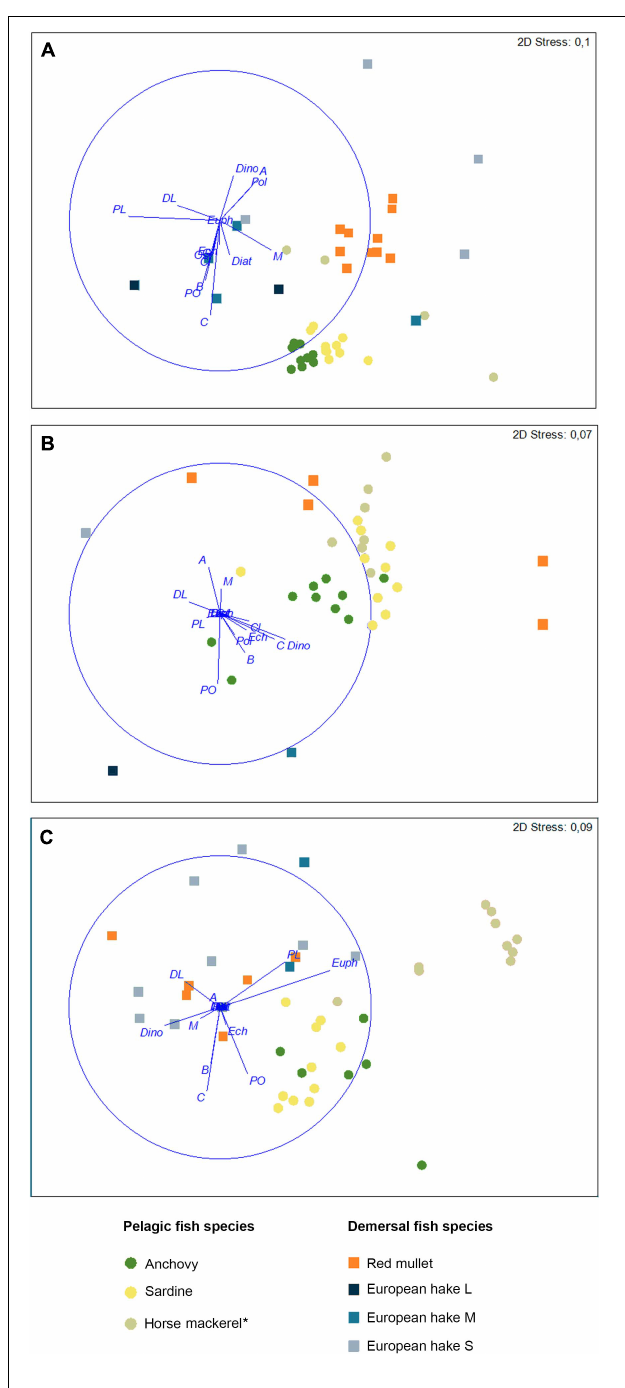
FIGURE 2 | nMDS ordinations showing individual variation in stomach contents of the investigated fish species in the (A) Northern, (B) Middle and (C) Southern areas in the Croatian part of the Adriatic Sea. Vectors show the relative strength and direction of correlations between prey abundance and the nMDS axes. Taxa are identified as: C, Copepoda; A, Amphipoda; M, Mysidacea; Eup, Euphausiacea; Cl, Cladocera; DL, Decapoda larvae; PO, Pisces ova; PL, Pisces larvae; B, Bivalvia larvae; G, Gastropoda larvae; Ech, Echinodermata larvae; Ost, Ostracoda; Pol, Polychaeta larvae; Dia, Diatomeae; Dino, Dinophyceae. *Mediterranean horse mackerel in the Northern and Middle areas and Atlantic horse mackerel in the Southern area.